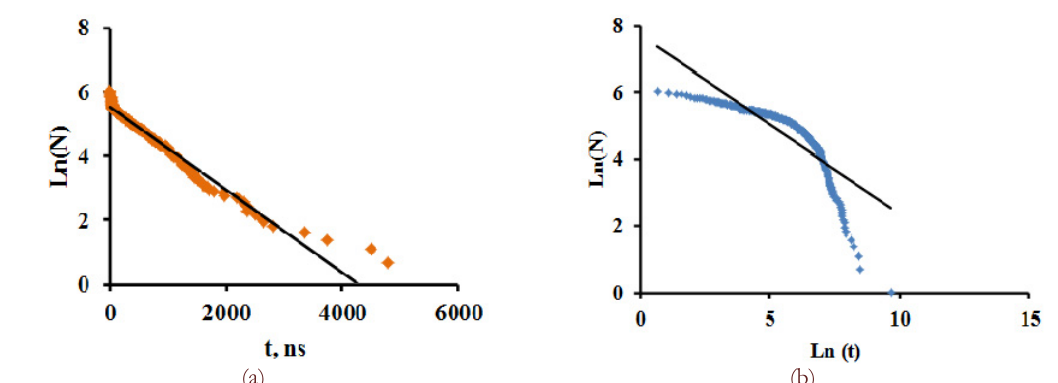
Figure 13: a) Cumulative distribution function of time interval for initial stage in a double logarithmic plot. b) Cumulative distribution function of time interval for initial stage in a coordinate system LN (N) –time t .